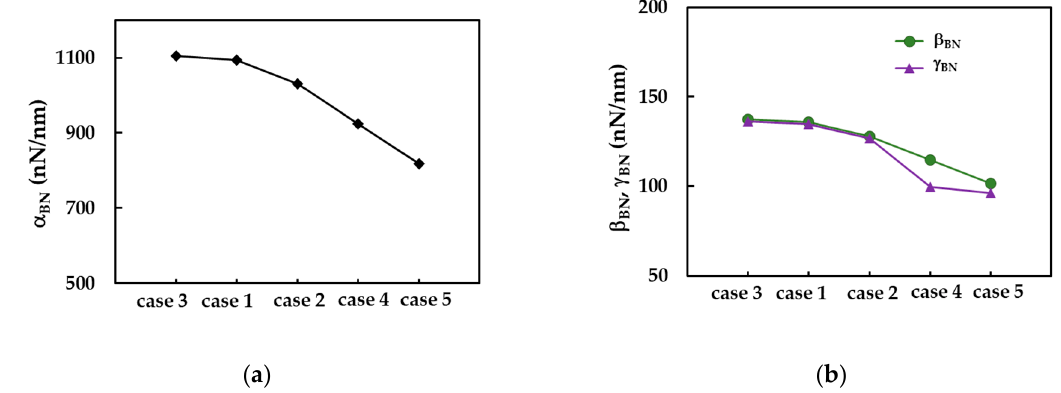
Figure 5. The evolutions of: ( a ) α BN , and ( b ) β BN and γ BN fitting parameters for the five cases of input values in the numerical simulation of SWBNNTs.